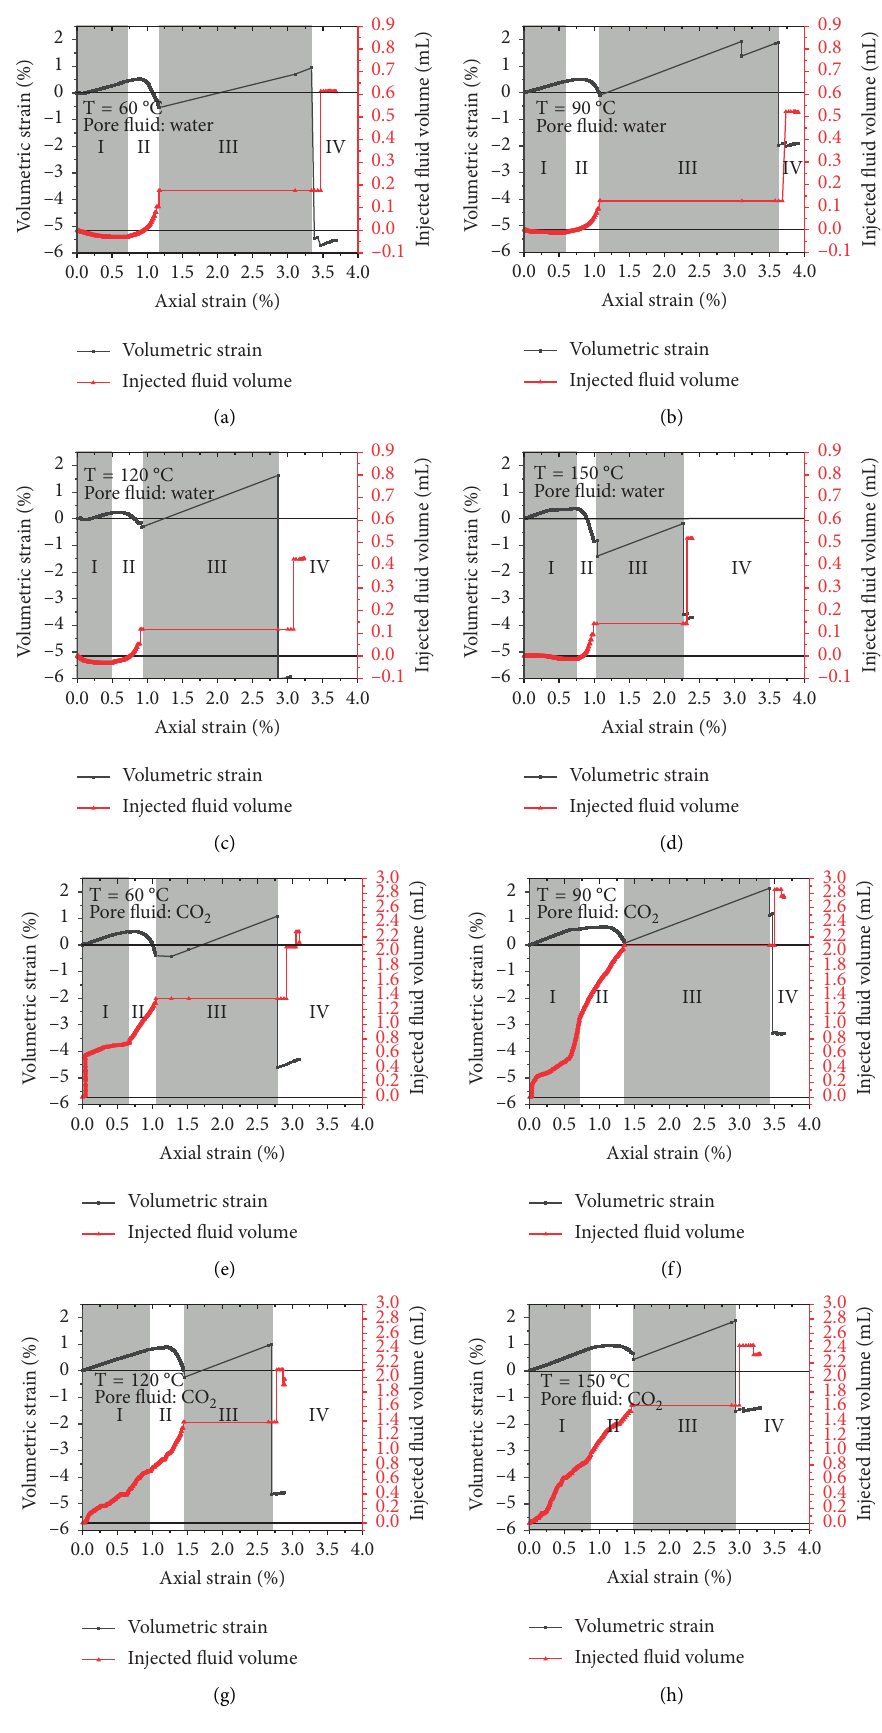
Figure 6: Volumetric strain-axial strain and injected fluid volume curves for the compression experiments under different pore fluid injection and temperature conditions. There are four common stages, that is, stage I, stage II, stage III, and stage